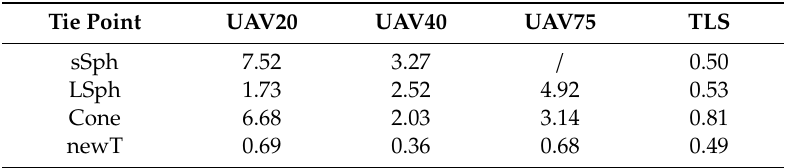
Table 10. The RMSE 3 D of the check points following the UAV and TLS point cloud registration into the referential measurements performed with MS50, provided in cm.